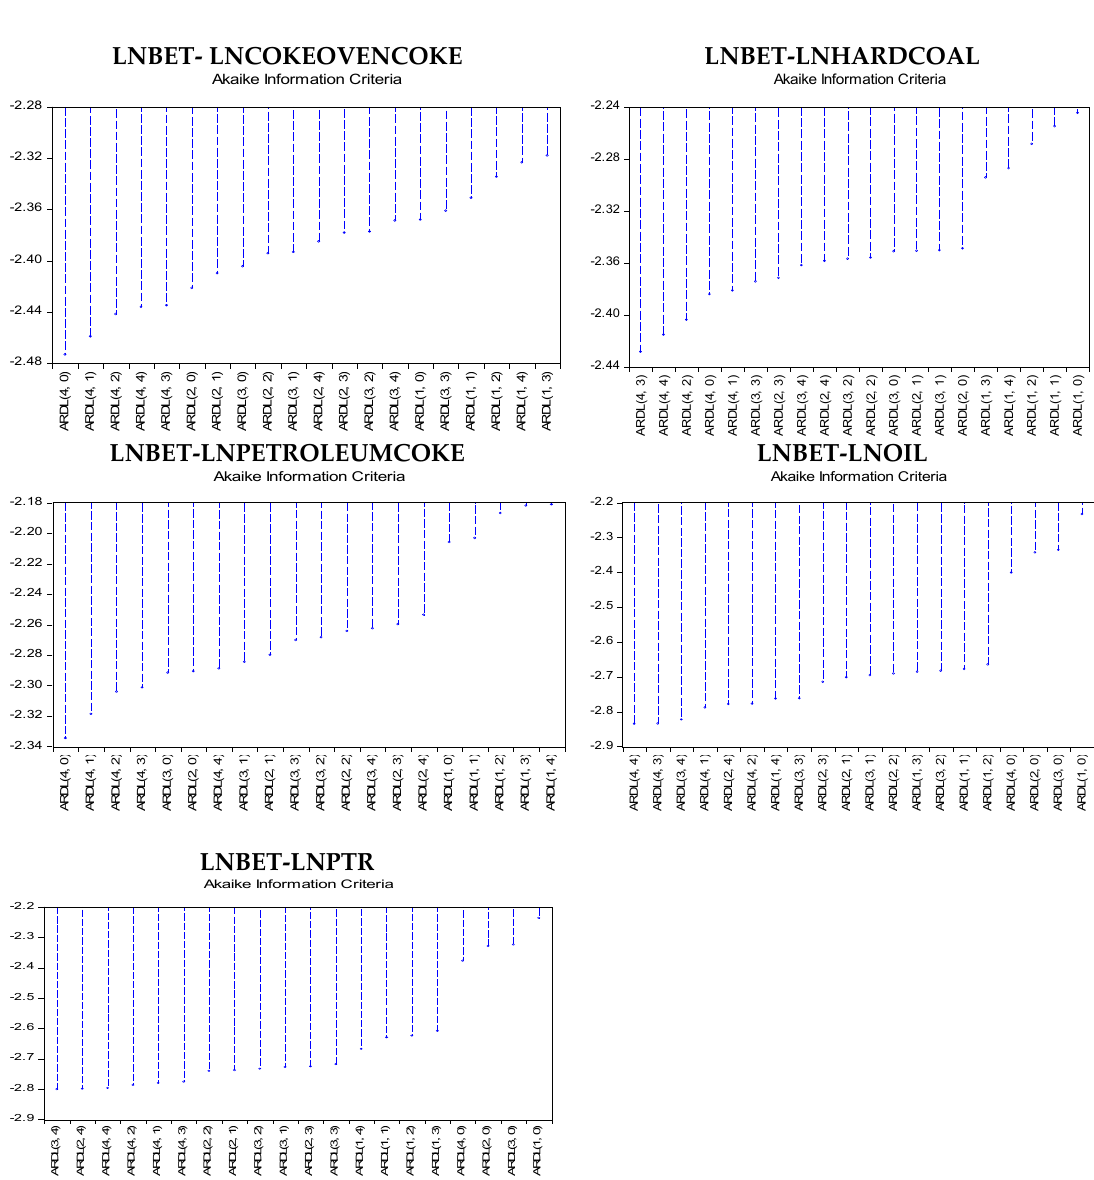
Table 11. The results of the ARDL bounds test.